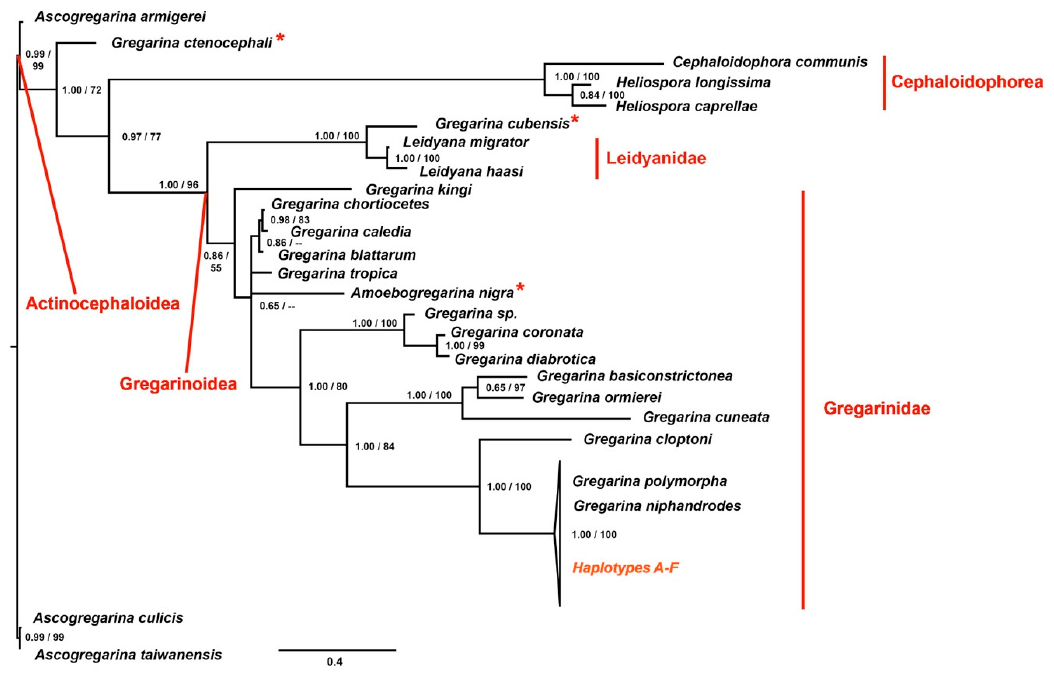
Figure 3. Phylogenetic tree obtained applying to each data set the Bayesian optimization criteria. At each node, the posterior probabilities (alone or before the slash) and the bootstrap values (when the node was shared among the Bayesian Inference (BI) and Maximum likelihood (ML) topologies and when > 50) are shown. Haplotypes A-F are the sequences of the 18S obtained in the present study. In red, the families and super-families are shown. The asterisks highlight taxa with unexpected grouping within the phylogenetic tree, that lead to para- or polyphyletic lineages.